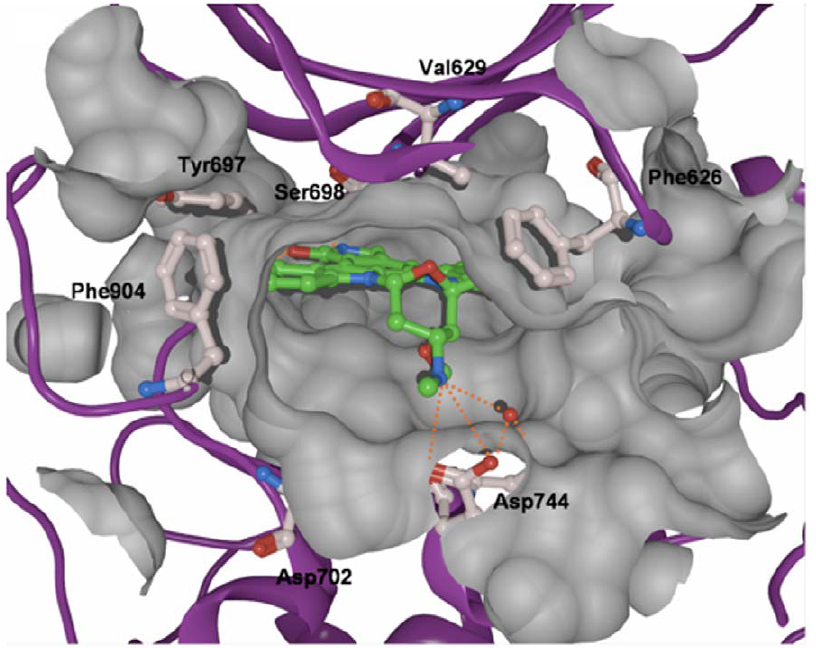
Figure 2. Interaction of staurosporine (carbon atoms in green) at the ATP binding pocket of PRK1. The molecular surface of the binding pocket is shown. Besides the hydrogen bonds with the hinge region, the protonated amino group of staurosporine donates hydrogen bonds (shown as orange dashed lines) to Asp744 and a conserved water molecule (shown in red). doi:10.1371/journal.pone.0034973.g002 PLoS ONE |